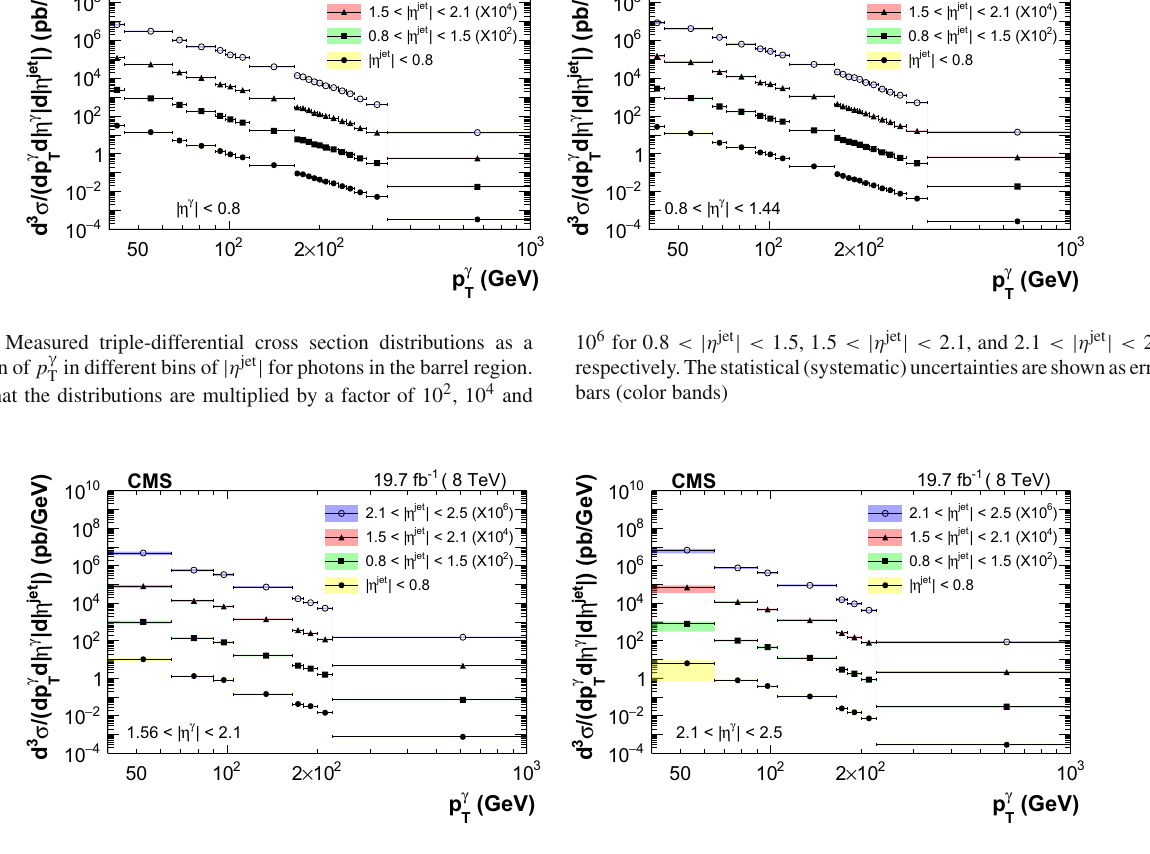
10 6 for 0 . 8 < | η jet | < 1 . 5, 1 . 5 < | η jet | < 2 . 1, and 2 . 1 < | η jet | < 2 . 5 respectively.Thestatistical(systematic)uncertaintiesareshownaserror bars (color bands)